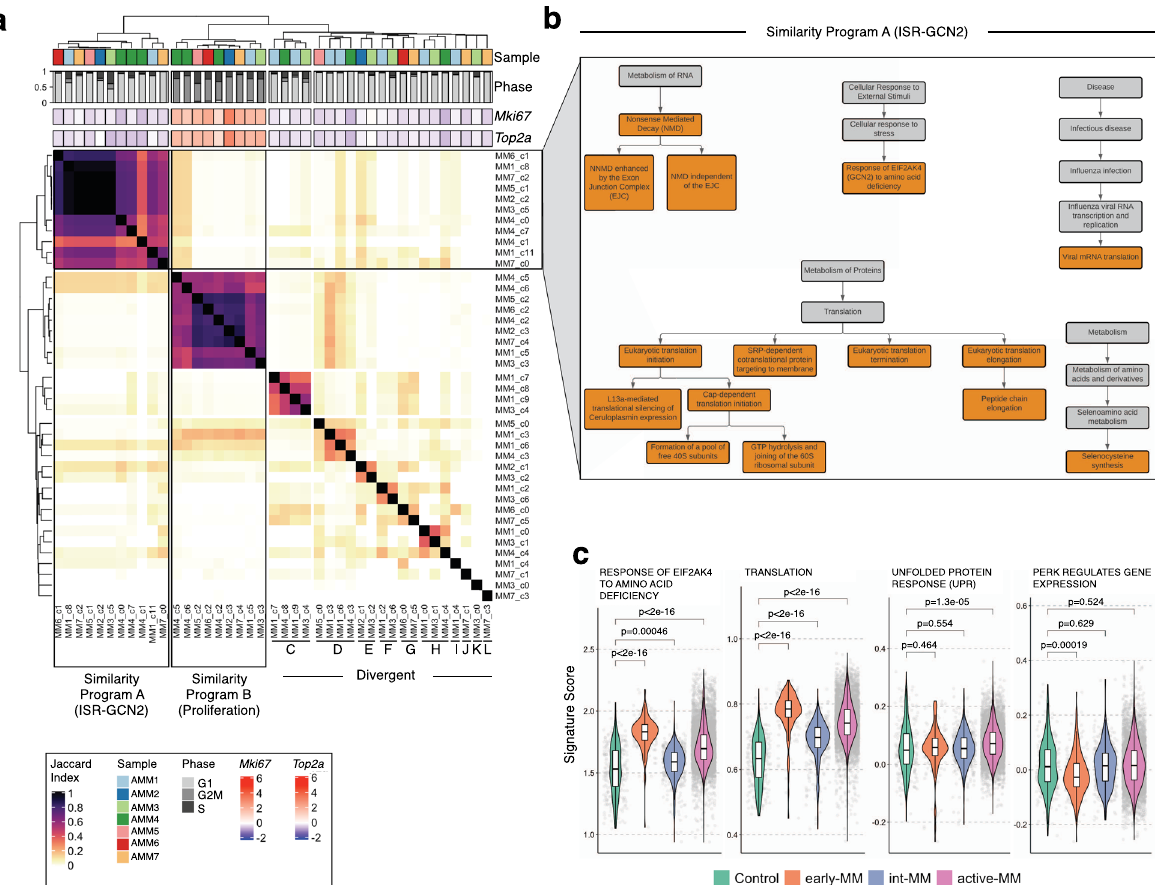
Fig. 4 Molecular programs driving intratumoural heterogeneity in V κ *MYC mice with active-MM. a Heatmap of Jaccard Index between signi fi cantly enriched Reactome terms across 41 intra-tumour malignant cell clusters. Groupings of clusters with increased similarity (Similarity Programs) were determined according to the complete linkage method for hierarchical clustering and are labelled below the heatmap. Columns are annotated with information related to sample identity, cell cycle phase, and Mki67 / Top2a expression. b Map of Reactome terms with signi fi cant enrichment in malignant cell clusters from Similarity Program A (ISR-GCN2). The full hierarchy of each Reactome pathway is shown for context but only signi fi cantly enriched shared pathways are highlighted in orange. c Gene set scoring for indicated Reactome signatures calculated using Seurat ’ s AddModuleScore across disease groups in V κ *MYC data (Control = 264 cells, early-MM = 168 cells, int-MM = 443 cells, active-MM = 5,969 cells). Boxplots within violin plots represent the distribution of each measurement within de fi ned groups, where the central rectangle spans the interquartile range, the central line represents the median, and “ whiskers ” above and below the box show the value 1.5× the interquartile range. Statistical comparison of multiple groups (normal PCs vs. each V κ *MYC disease group) was performed using the Wilcoxon rank-sum test (two-sided) corrected for multiple testing (Benjamini − Hochberg). Source data are provided in SourceData_Fig.